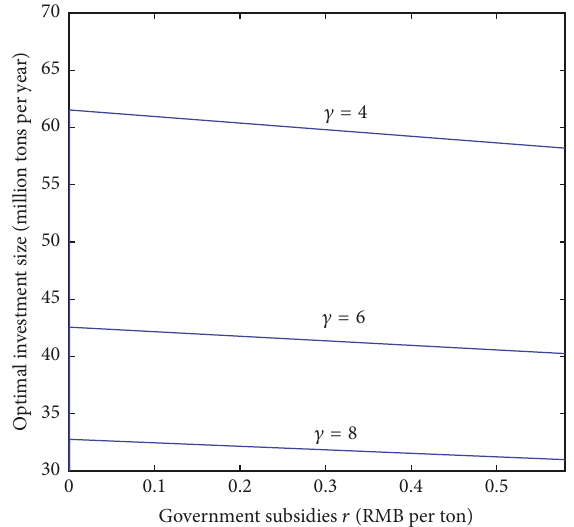
Figure 4: Change of the logistics demand threshold with the discount rate and project construction duration.